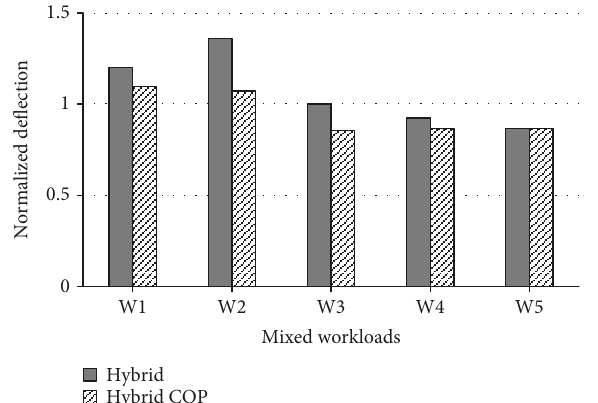
Figure 13: Normalized energy of the hybrid loads with 64 threads.